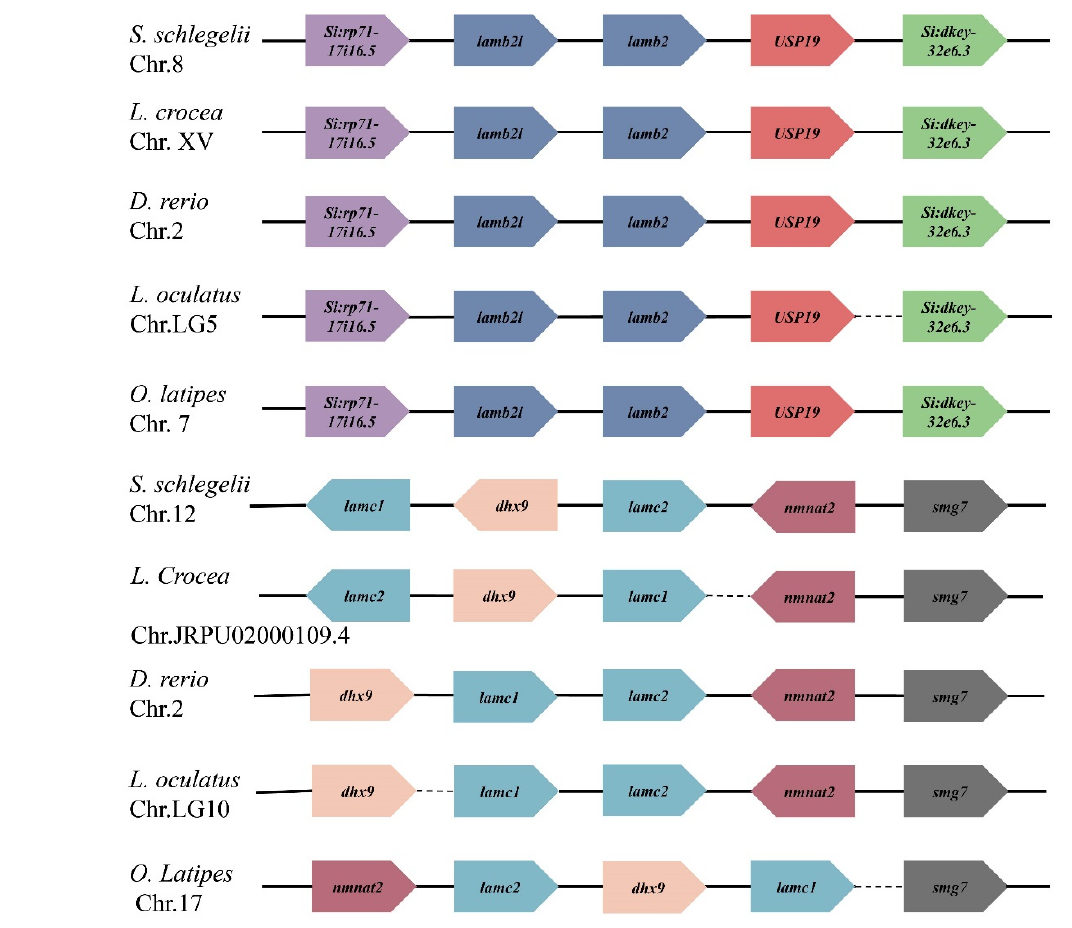
Figure 3. The position of tandem laminin genes in teleosts. The arrow direction indicates the direction of transcription. Dashed lines indicate discontinuities between genes. Genes of the same gene or family are represented in the same color. ( a ) Orders of lamb2 and lamb2l in teleosts; ( b ) Orders of lamc1 and lamc2 in teleosts.